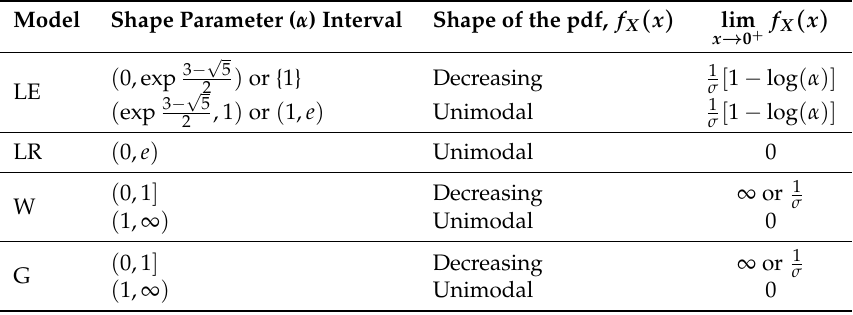
Table 1. Comparison of the Lambert-exponential (LE), Lambert–Rayleigh (LR), Weibull (W) and gamma (G) models in terms of the pdf.